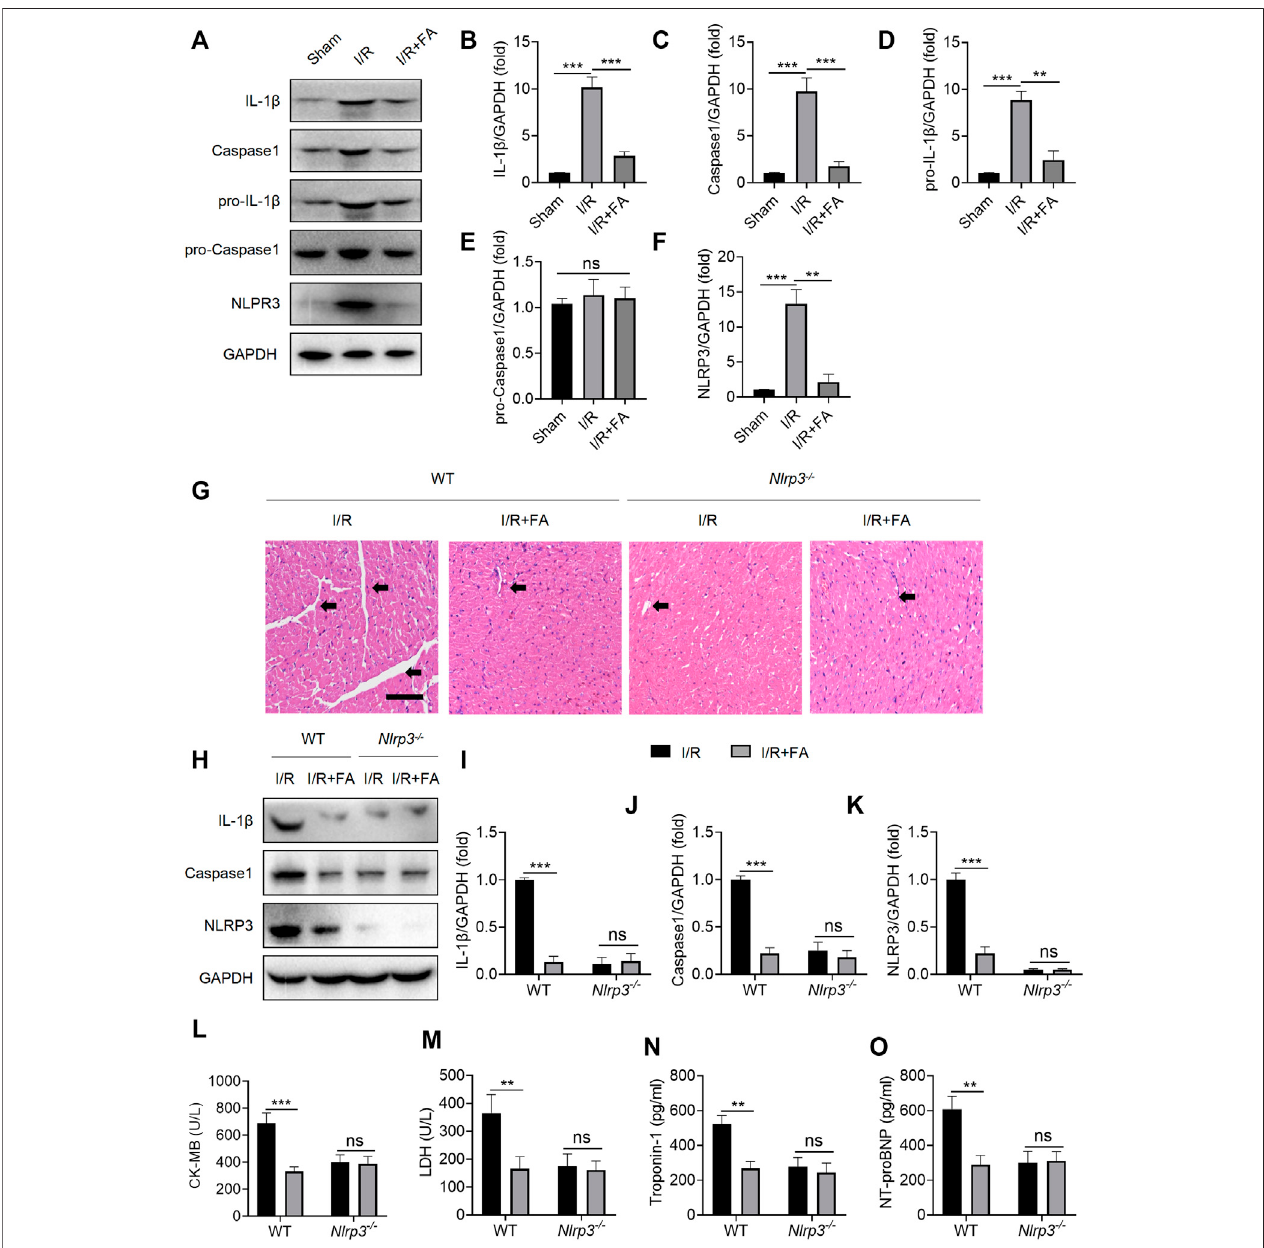
FIGURE 8 | FA inhibits I/R-induced myocardial injury by inhibiting NLRP3 in fl ammasome activation. (A – F) Expression of NLRP3, pro-caspase-1, caspase-1, pro- IL-1 β ,andIL-1 β inthehearttissueofWTmicewasdetectedbywesternblotting. (G) HEstainingofhearttissuesectionsinWTmiceand Nlrp3 − / − mice. (H – K) Expression of IL-1 β , caspase-1, and NLRP3 in heart tissues of WT mice and Nlrp3 − / − mice in each experimental group, detected by western blotting. (L – O) Expression of CK-MB, LDH,troponin-1,andNT-proBNPintheserumofeachexperimentalgroupinWTmiceand Nlrp3 − / − mice,determinedbyELISA.Dataareexpressedasthemeans± sd from three independent experiments or are representative of three independent experiments. ** p < 0.01, *** p < 0.001; ns indicates no signi fi